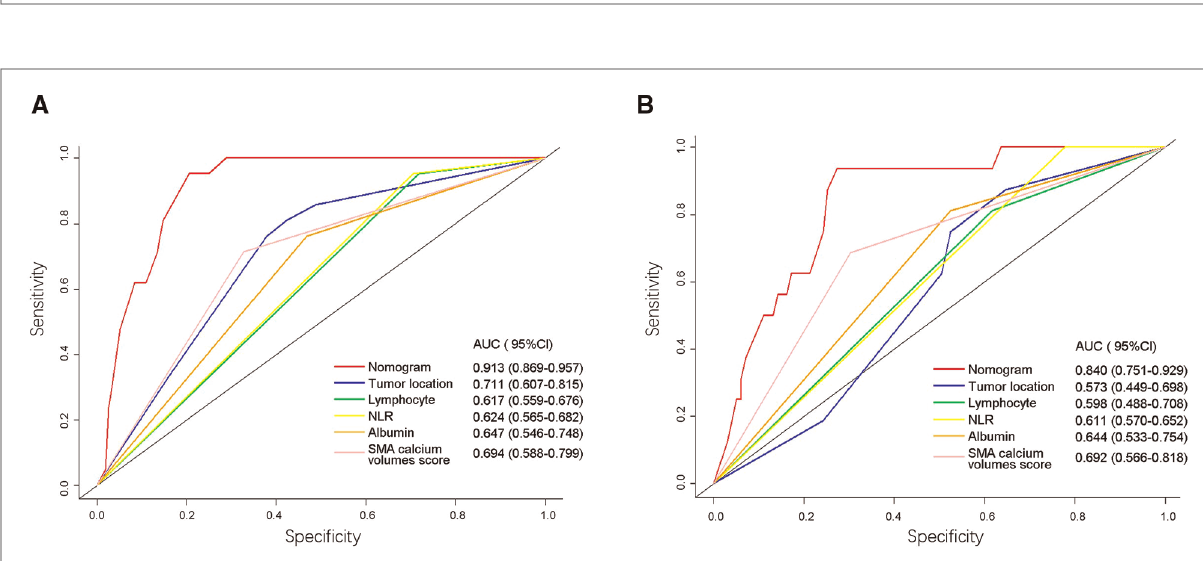
FIGURE 5 The calibration curves of the nomogram in the training cohort ( A ) and validation cohort ( B ). The X -axis represented the possibility of AL predicted by the nomogram, and the Y -axis represented the possibility of AL observed in patients.